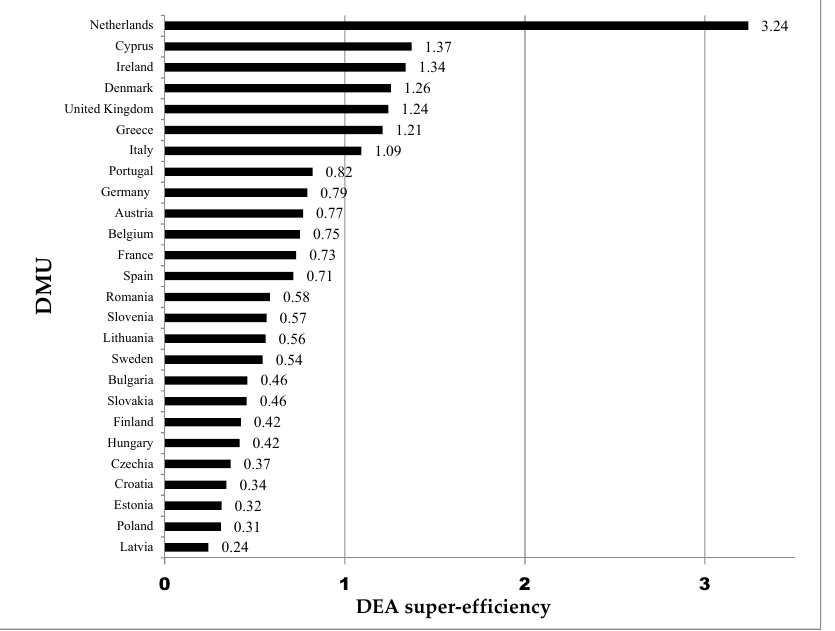
Figure 3. The economic and energy efficiency of EU agriculture based on the DEA method (2019).